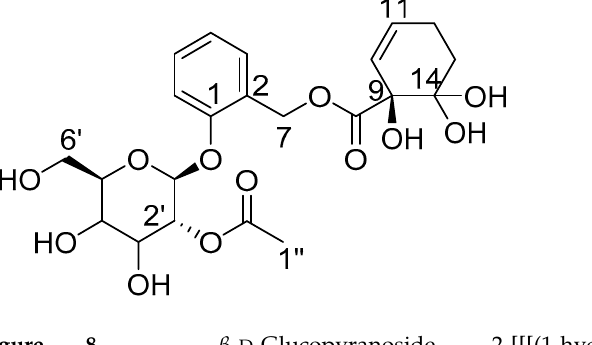
Figure 8. β - D -Glucopyranoside, 2-[[[(1-hydroxy-6,6-dihydroxy-2-cyclohexen-1-yl)dihydroxy]oxy]methyl]phenyl, 2-acetate comprising a geminal diol at position C(14) of the HCH moiety.